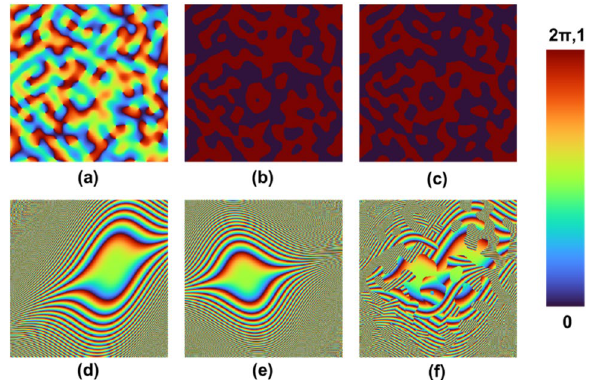
Figure 2. Design of the randomly multiplexed phase mask. ( a ) Random matrix S varying between 0 and 1. ( b ) Binary random matrix S 1 and ( c ) complementary binary random matrix S 2 . Phase distribution of phase modulators ( d ) PM 1 and ( e ) PM 2 . ( f ) Random phase multiplexed mask S 1 × PM 1 + S 2 × PM 2 . The images are generated using MATLAB (version R2020b) 36 .